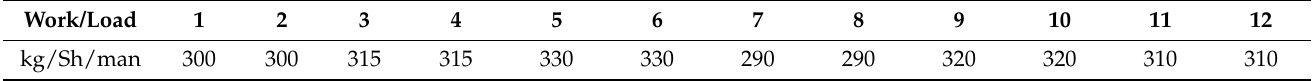
Table 1. Iron works of monolithic foundation—performance